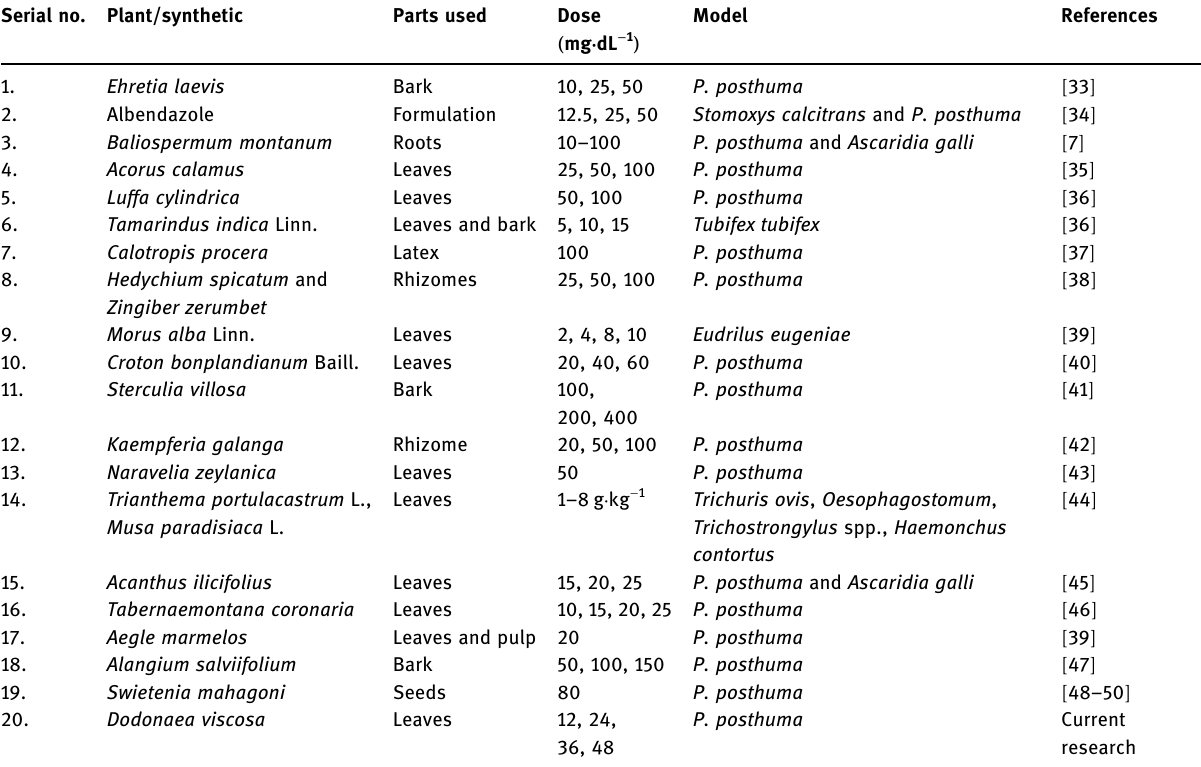
Table 4: Comparative anthelmintic activity of di ff erent herbal and synthetic drugs Serial no.